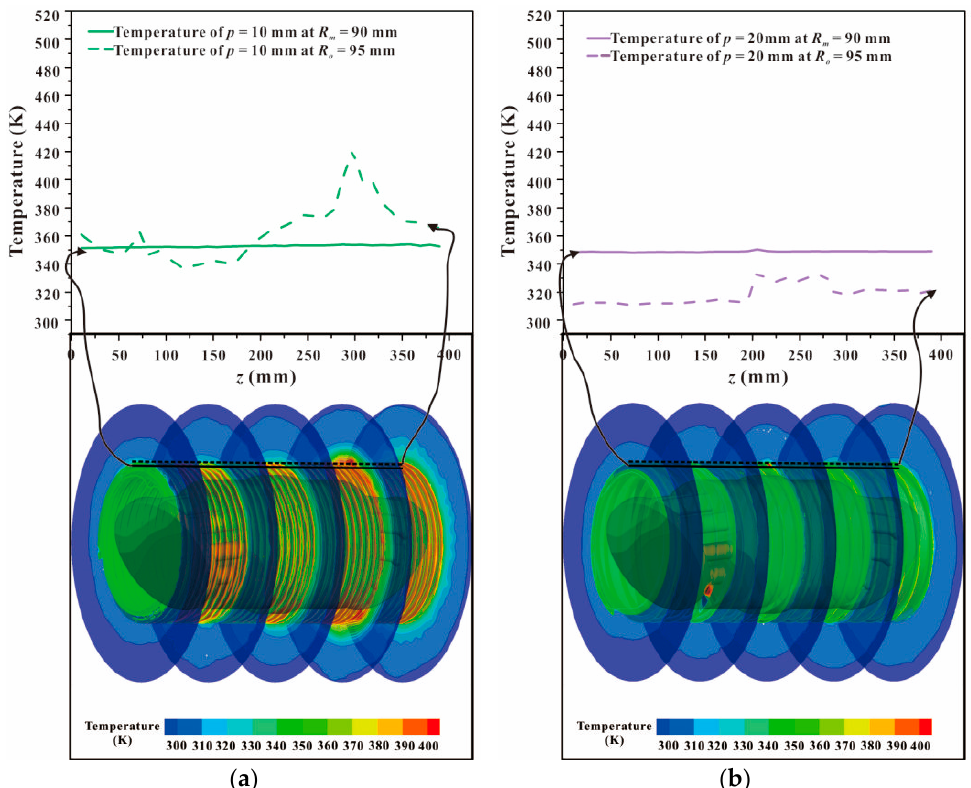
Figure 10. Temperature distribution with a fin height h = 10 mm and fin thickness t = 2 mm when ( a ) fin pitch p = 10 mm; ( b ) fin pitch p = 20 mm.